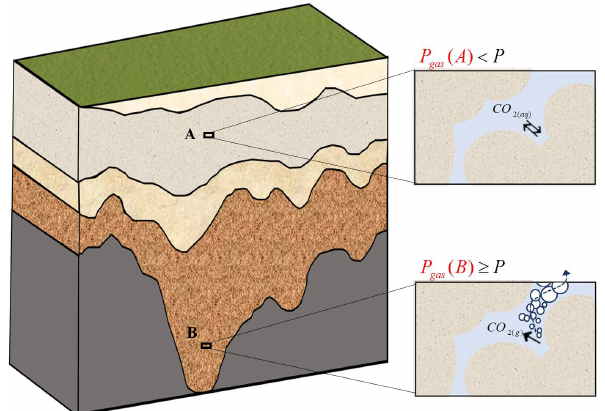
Figure 1. Outline of the two possible alternative scenarios accord- ing to the conceptual approach proposed in Cathles and Schoell (2007). At location A (characterized by shallow location and mod- erate T – P values), the geochemical system is at equilibrium, the total gas pressure given by sum of all gases species partial pressures ( P gas ) is smaller than porewater pressure ( P ), and the CO 2 exists only as dissolved species. At location B (characterized by deep lo- cation where high T – P values are expected), the total gas pressure is larger than porewater pressure. Then a CO 2 -rich gaseous phase is formed, which migrates upwards, and a disequilibrium is promoted, leading to continuous release of CO 2 until one of the reactants of the CCR is